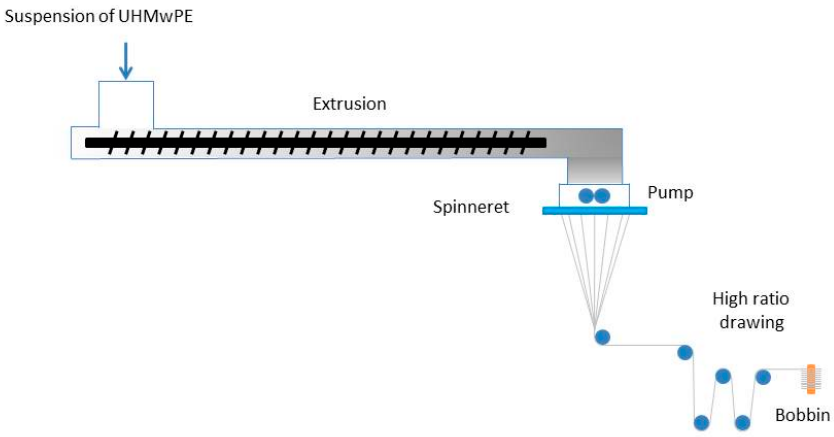
Figure 1. Gel spinning process.